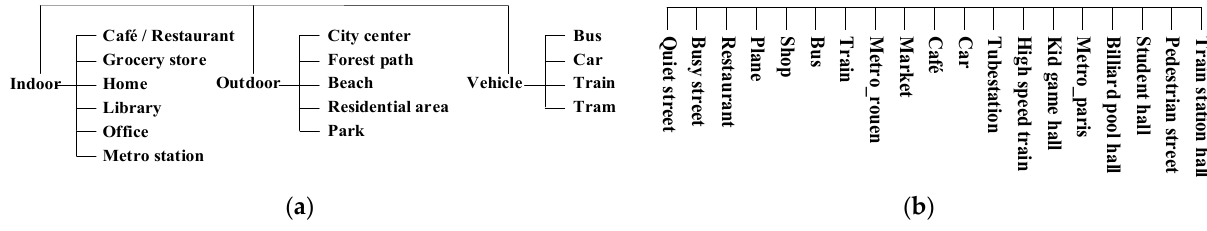
Figure 1. Different organizations of the label spaces. The label space of TUT Acoustic Scenes 2017 dataset is originally organized as a two-level hierarchy, however, merely single-level labels are provided in the LITIS Rouen dataset. ( a ) Labels of the TUT Acoustic Scenes 2017 dataset. ( b ) Labels of the LITIS Rouen dataset.